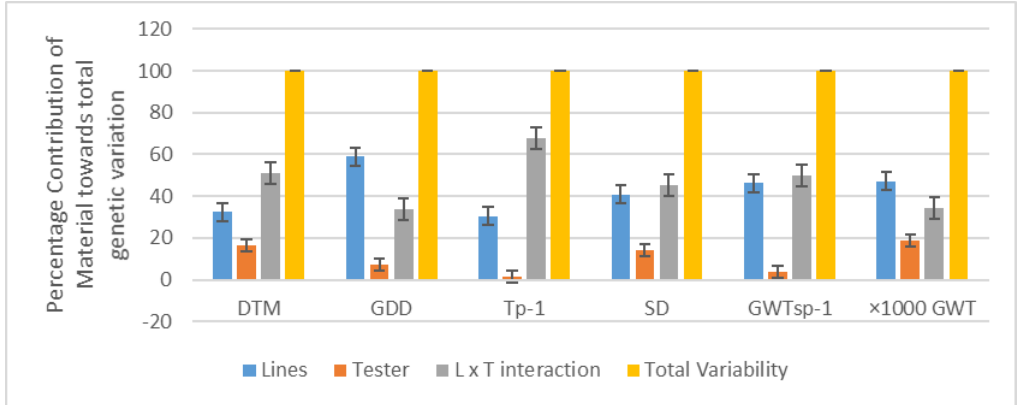
Figure 3. Contribution of material towards variability. DTM, Days to 50% maturity; GDD, Growing degree days (heat unit); Tp −1 , Productive tiller plant −1 ; SD, Spike density; GWTsp −1 , Grain weight spike −1 (g); × 1000 GWT, 1000 grain weight (g).